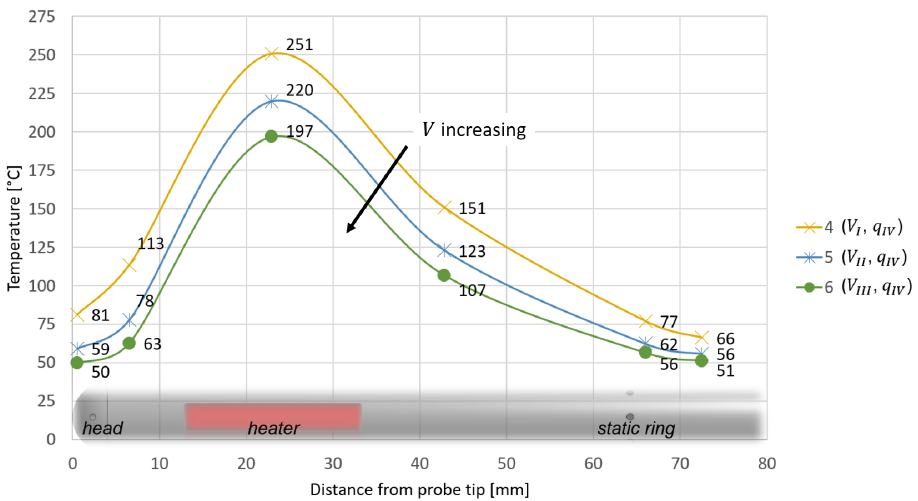
Figure 12. Measured temperature profiles for the test configurations 4, 5 and